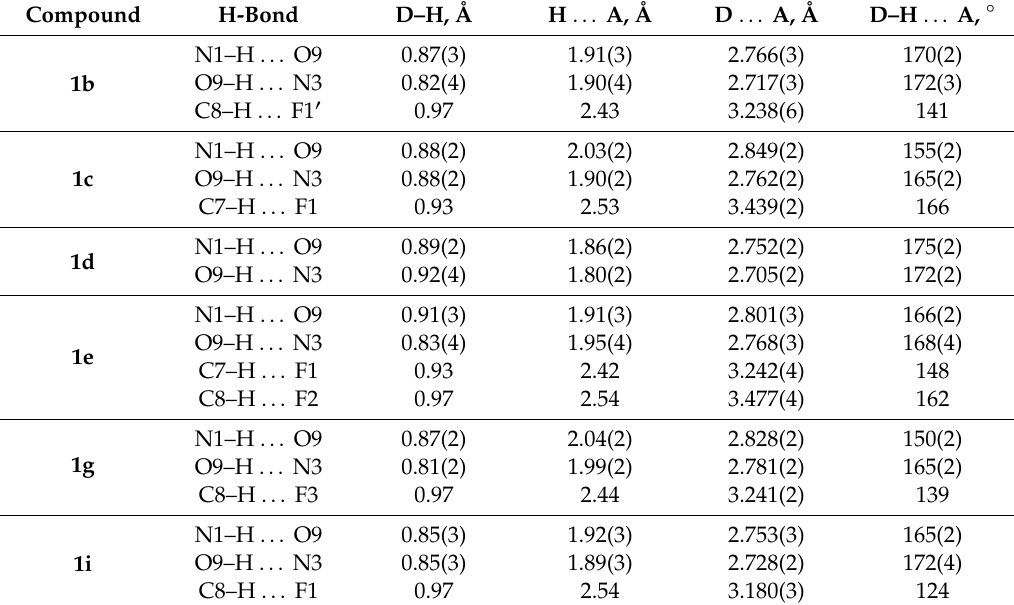
Figure 6. Fragments of the hydrogen-bonded framework in the crystal of compound 1i . Table 1. Geometric parameters of H-bonds for 1b – e , 1g , and 1i.